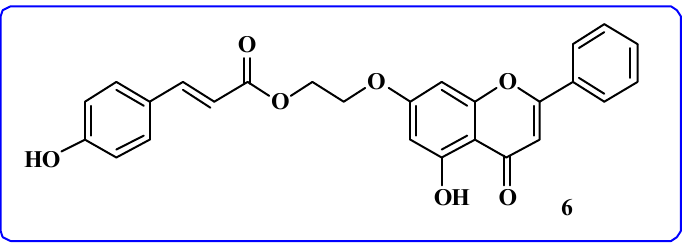
Figure 4. The structure of compound 6. Table 3. The structure of compounds 7a – 7j and 7q .